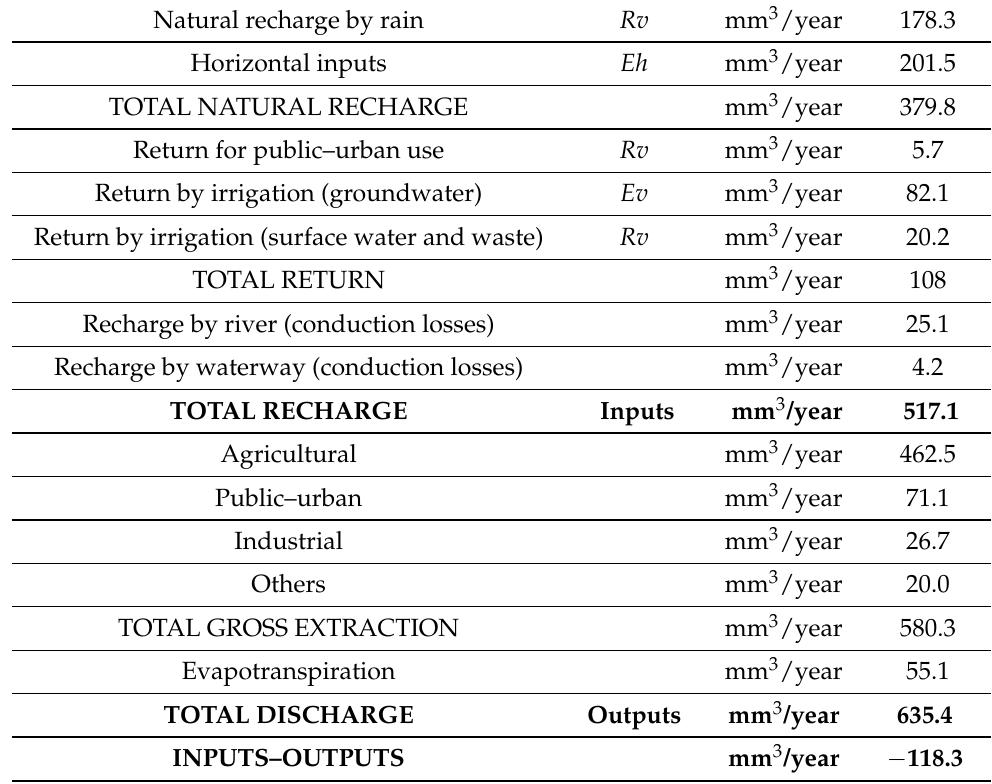
Table 2. Variables for calculating the groundwater balance in the Valle de Celaya aquifer in the rainy